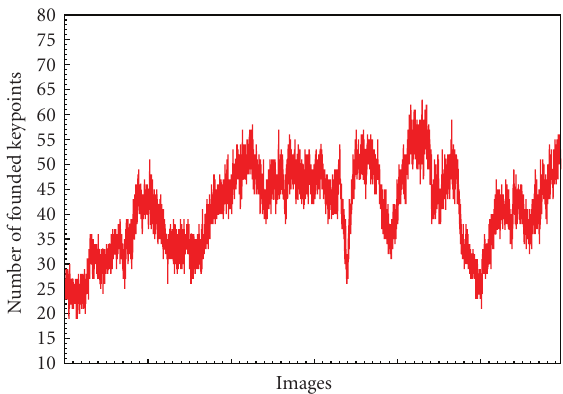
Figure 12: Number of detected keypoints in image sequence.